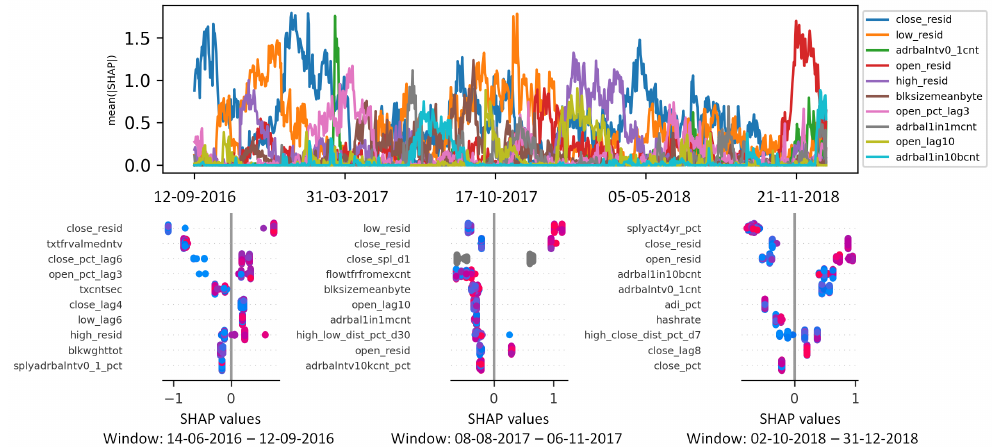
Figure 7. Interactive dashboard snapshot. Downtrend class. BTCUSD. Sliding training window size W =